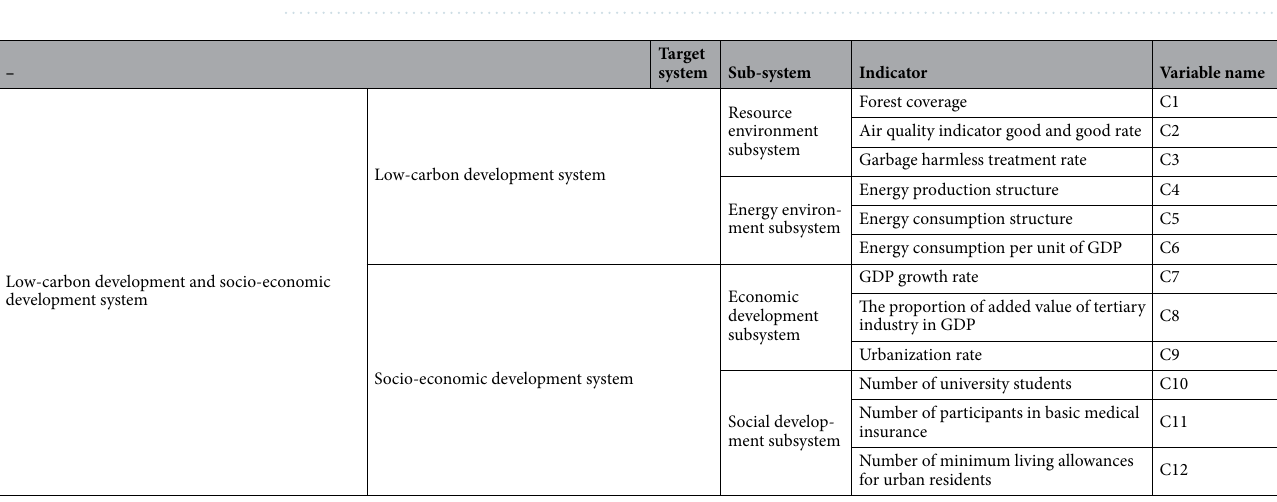
Figure 1. Located of Anhui Province in China.